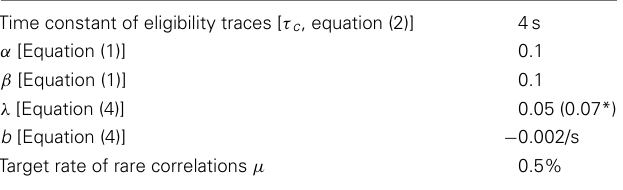
TableA1 | Parameters of the plasticity rule (RCHP) and modulation.